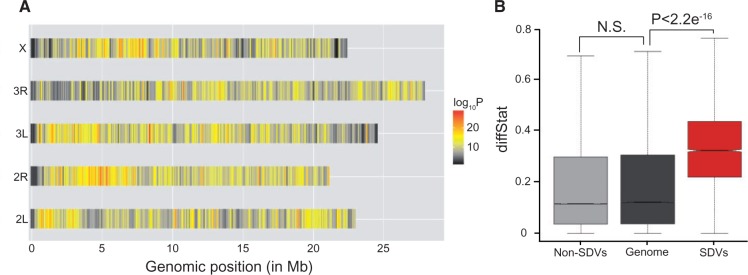
Distribution of SDV and diffStat statistic. (A) Distribution of significant variants in the five chromosome arms in the Drosophila melanogaster genome. (B) Comparison of the diffStat statistic between the significant variants (red), nonsignificant variants (light gray), and the genomewide background (dark gray).